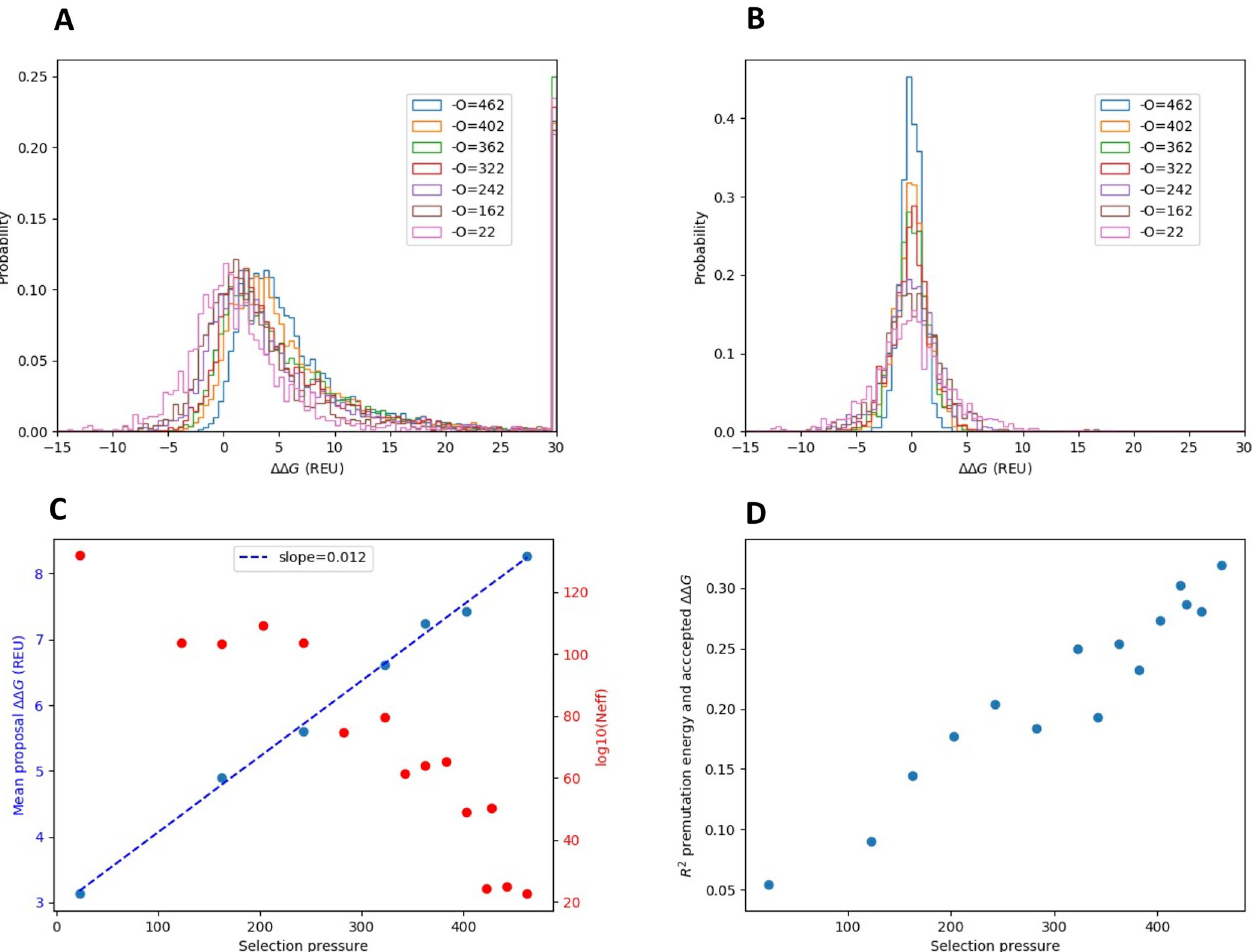
Fig 3. The selection pressure affects the ΔΔ G proposal and acceptance probability distribution. A) Proposal ΔΔ G probability distribution as function of selection pressures. Values above 30 energy units (corresponding to severe atomic clashes) were placed in the highest bin. B) Accepted ΔΔ G probability distribution as function of selection pressure. C) Mean proposal ΔΔ G value (correspond to the distribution < 100 energy units) as a function of selection pressure(blue), with a fitted line (blue). The logarithm of number of available sequences as a function of selection pressure (red) calculated with an assumption of independent sites in the protein. Energies in Rosetta Energy Units (REU). D) Correlation between premutation energy and accepted ΔΔ G values as a function of selection pressure. Correlations are measured as squared Pearson correlation coefficients.